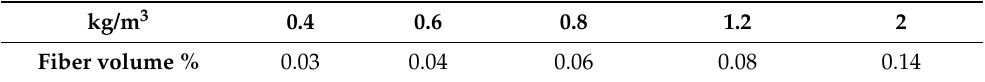
Table 4. Fiber content in kg/m 3 and in percentage by volume.